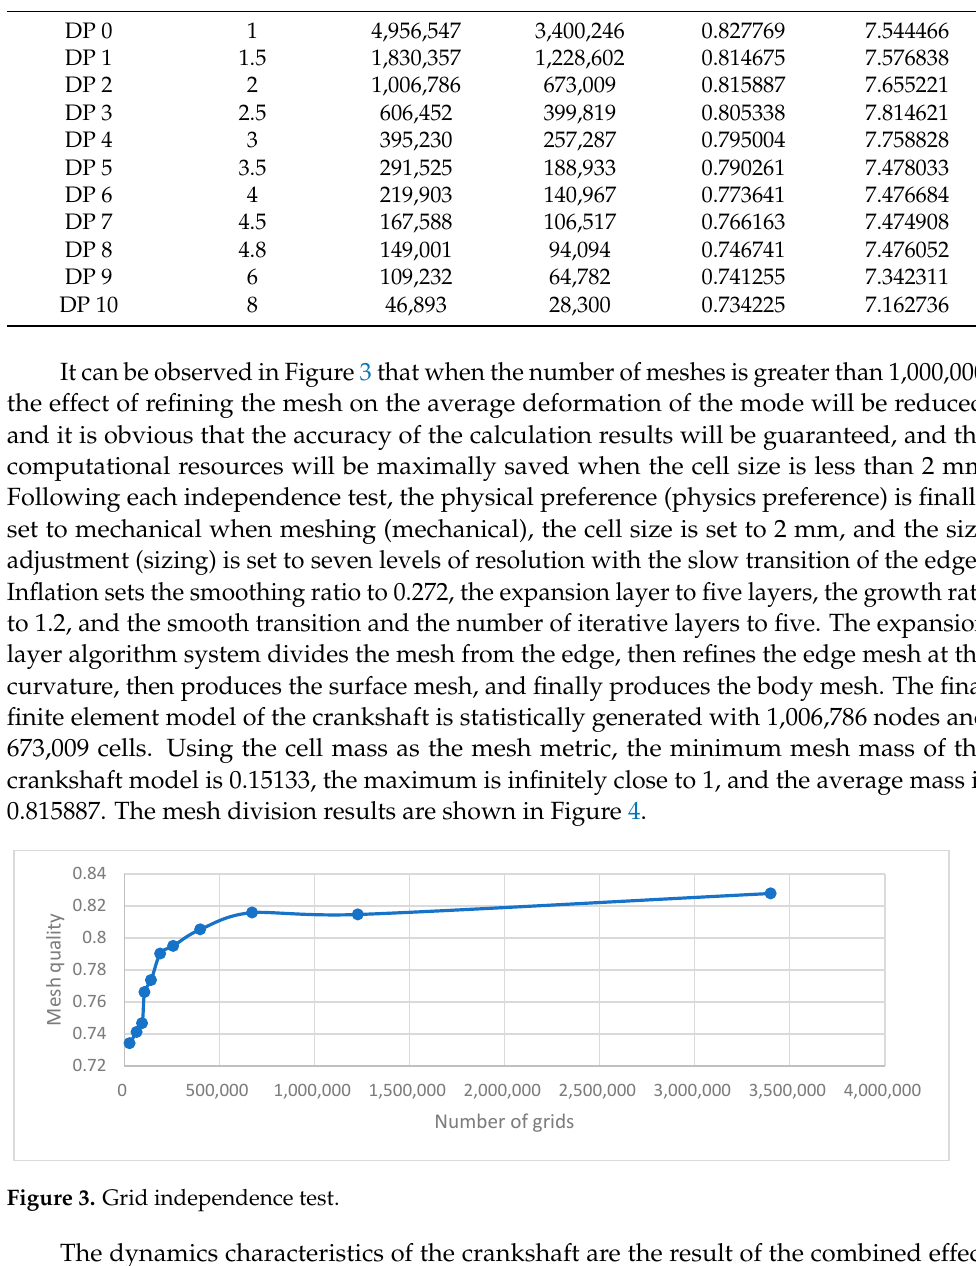
Figure 4. Crankshaft meshing results.